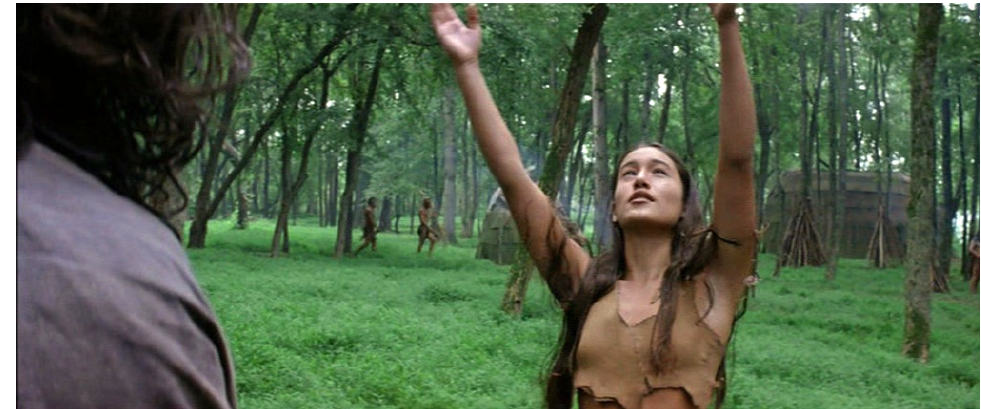
Figure 6: Pocahontas’ language lesson involves the intermingling of the actions of her salutation practice and its seeming